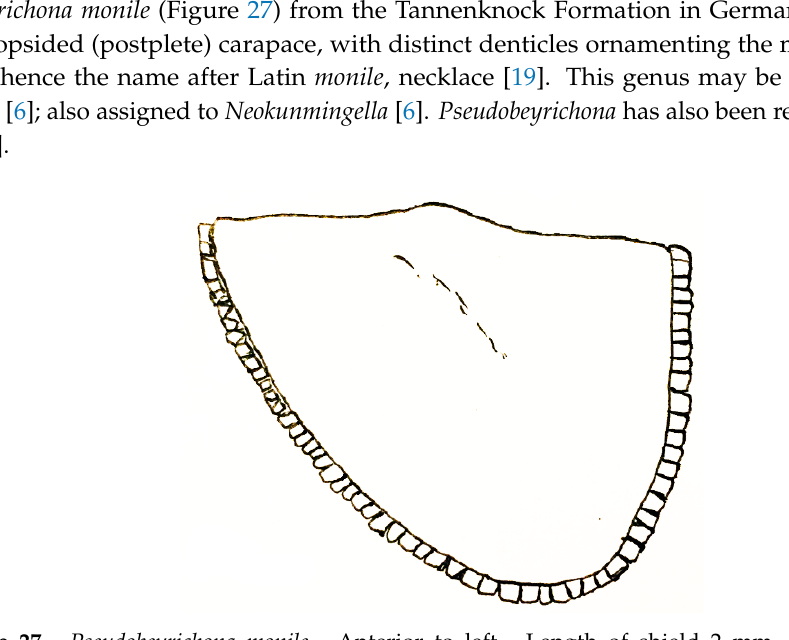
Figure 27. Pseudobeyrichona monile . Anterior to left. Length of shield 2 mm. Image Credit: Mark McMenamin.